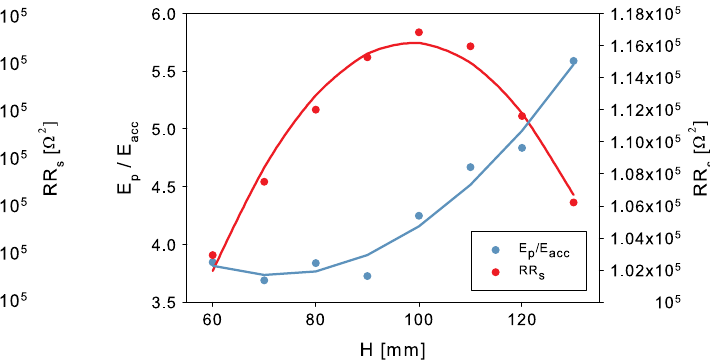
FIG. 29. Dependence of the normalized electric field and RR s on the parameter